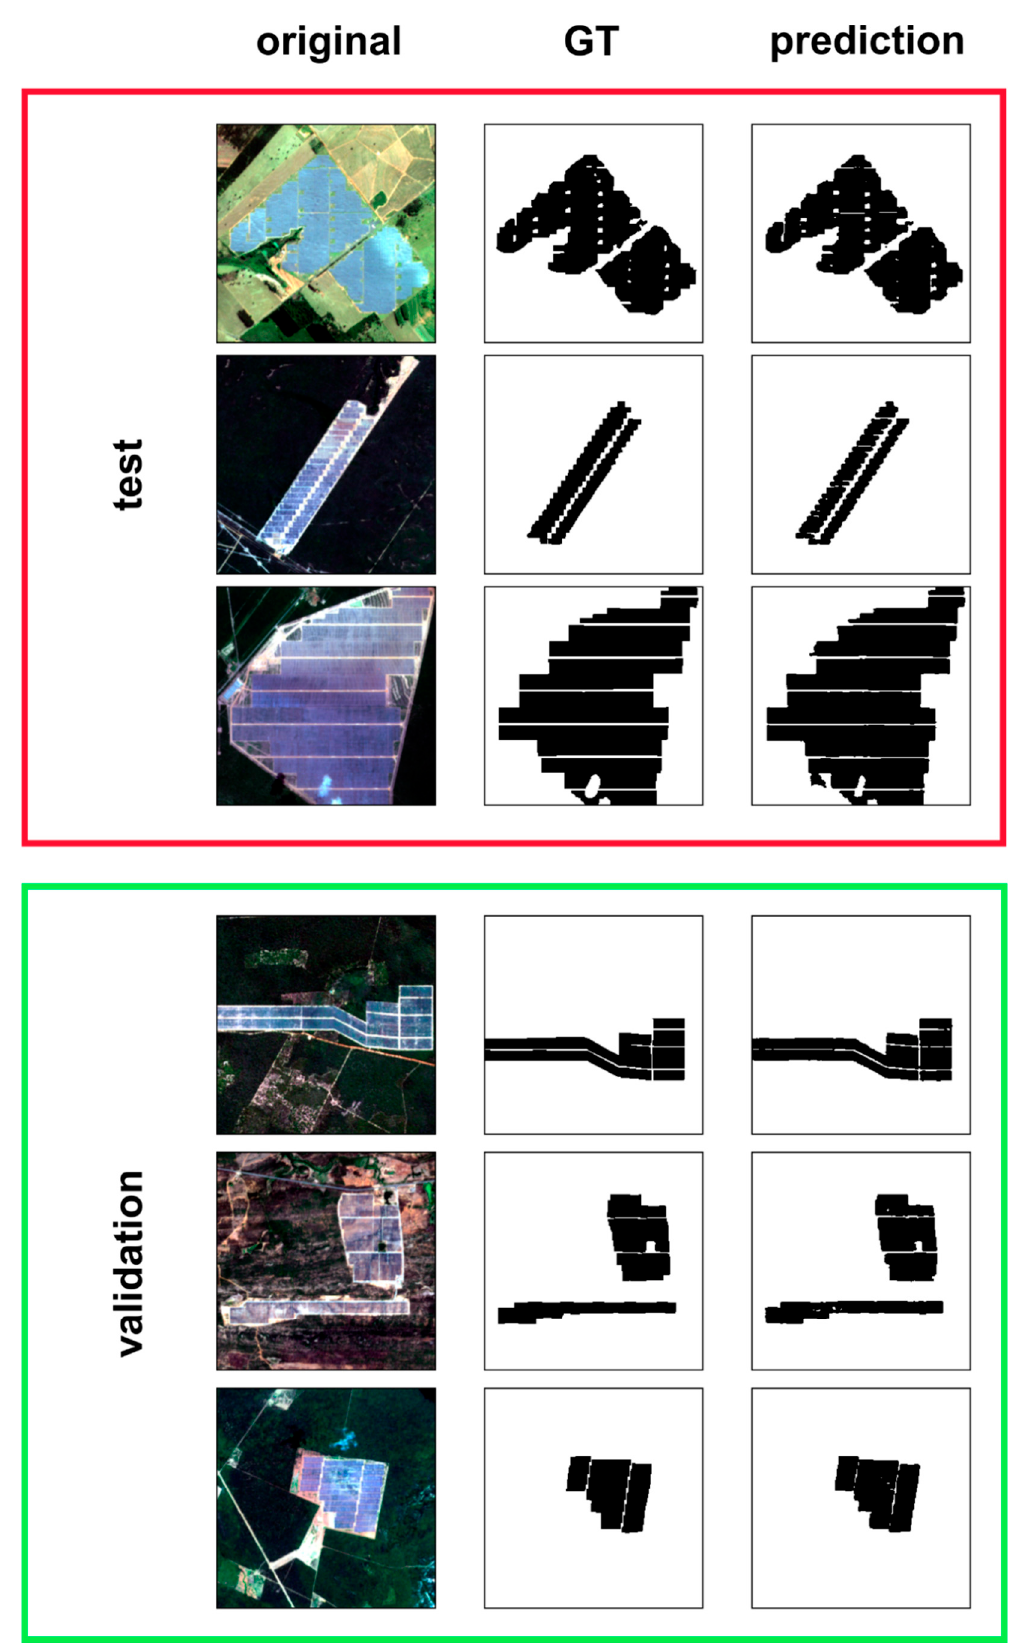
Figure 4. Three examples from the test set and three examples from the validation set with their corresponding original image, ground truth (GT), and prediction.